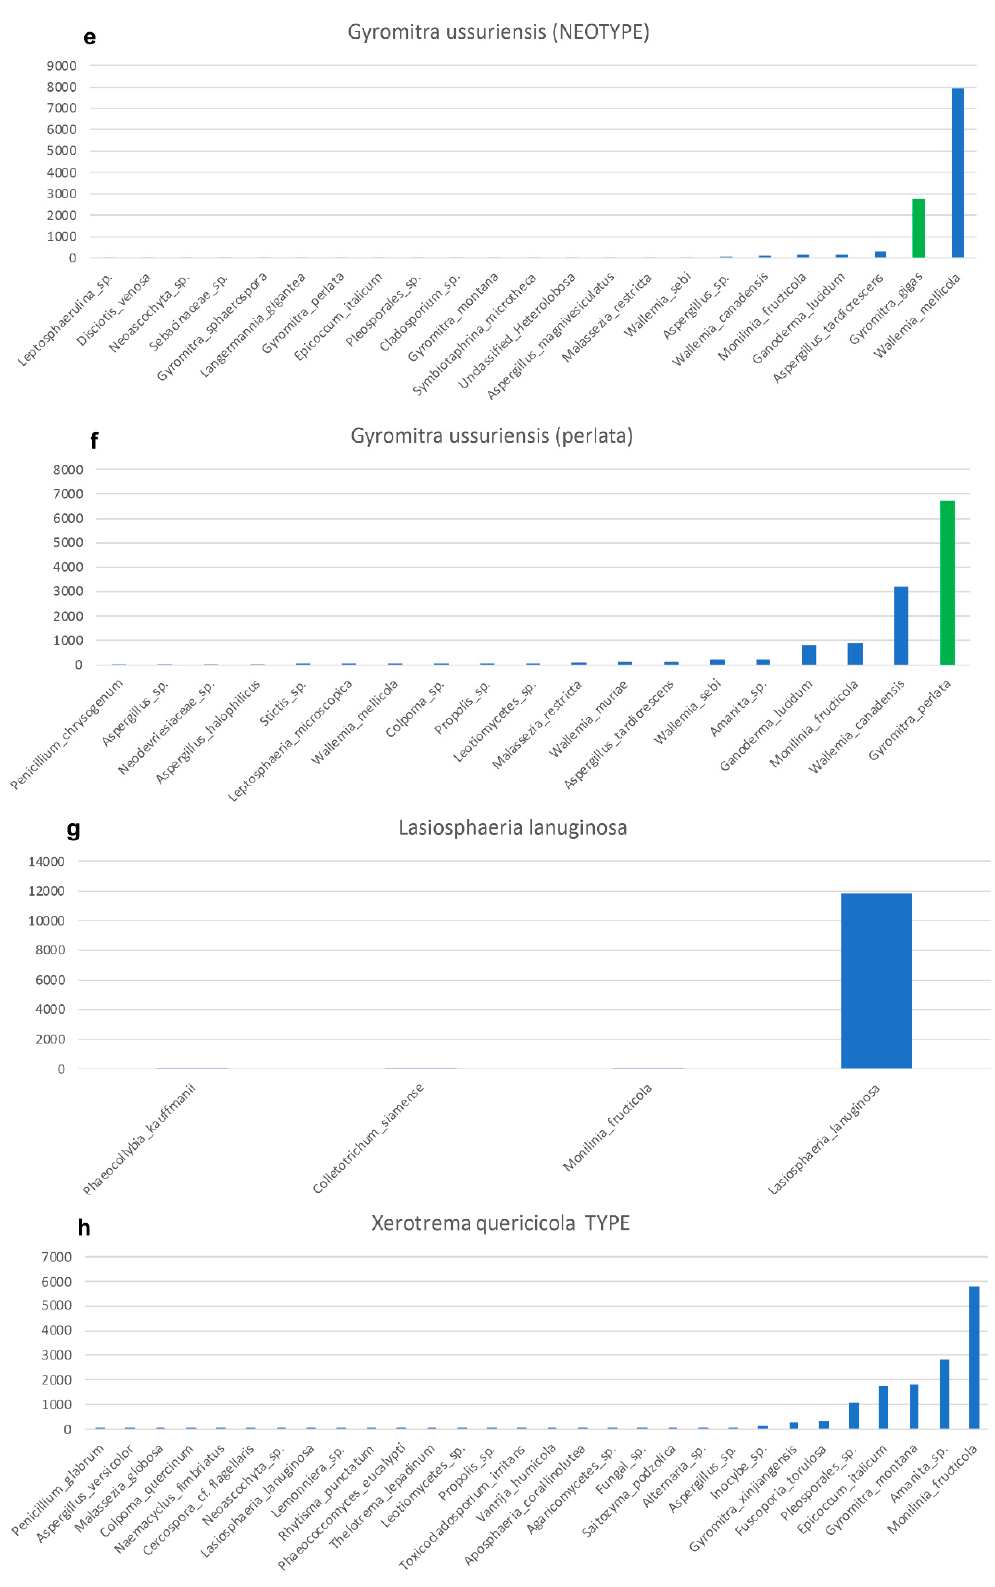
Figure 3. Taxonomic assignments shown as increasing number of Illumina-generated ITS2 sequences for each sample. Bars are shown in green for all species in the genus, Gyromitra . ( a ) Discina repanda . ( b ) Gyromitra arctica . ( c ) Gyromitra korshinskii . ( d ) Gyromitra leucoxantha . ( e ) Gyromitra ussuriensis . ( f ) Gyromitra ussuriensis . ( g ) Lasiosphaeria lanuginosa . ( h ) Xerotrema quericola